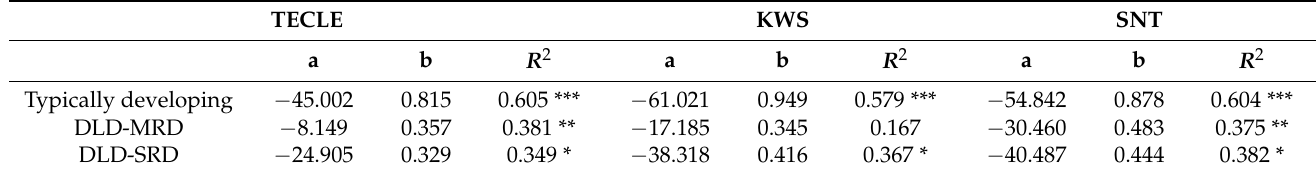
Table 1. Slopes (b), intercepts (a), and coefficient of determination ( R 2 ) of the regression equations calculated on the percentage of correct answers on the TECLE, KWS, and SNT tasks, according to age, for the different groups (typically developing, DLD-MRD, and DLD-SRD). TECLE KWS SNT a b R 2 a b R 2 b R 2